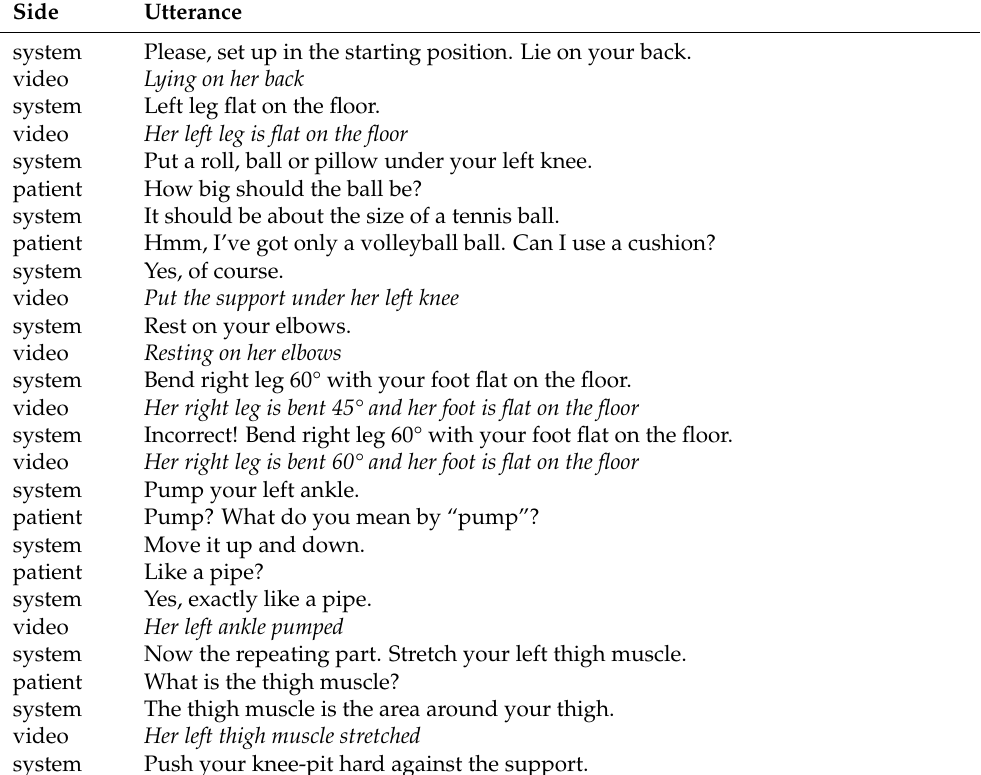
Table 7. Conversation with the data-driven model. A dialogue involving a single repetition of the “Quads over a roll” exercise for left leg, conducted by one of the